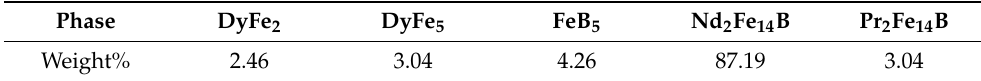
Table 2. Rietveld XRD- quantitative analysis of NdFeB-magnets.